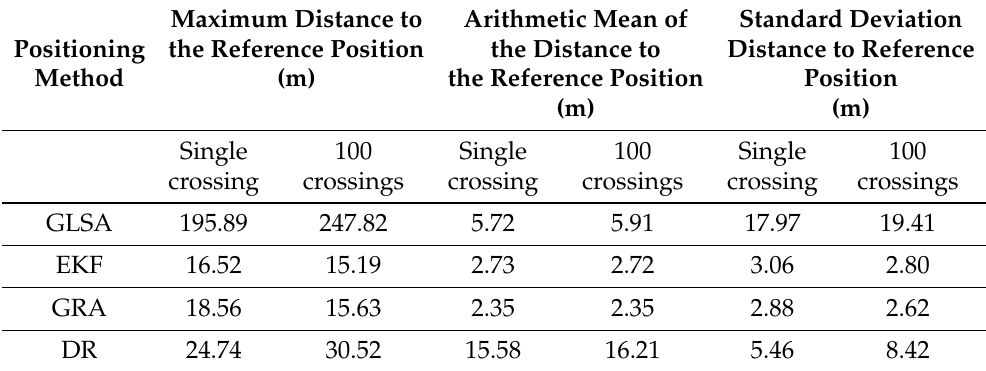
Table 1. Statistical parameters of the scatter of the distance to the reference position from the positions estimated by the GLSA, EKF, GRA, and DR methods.